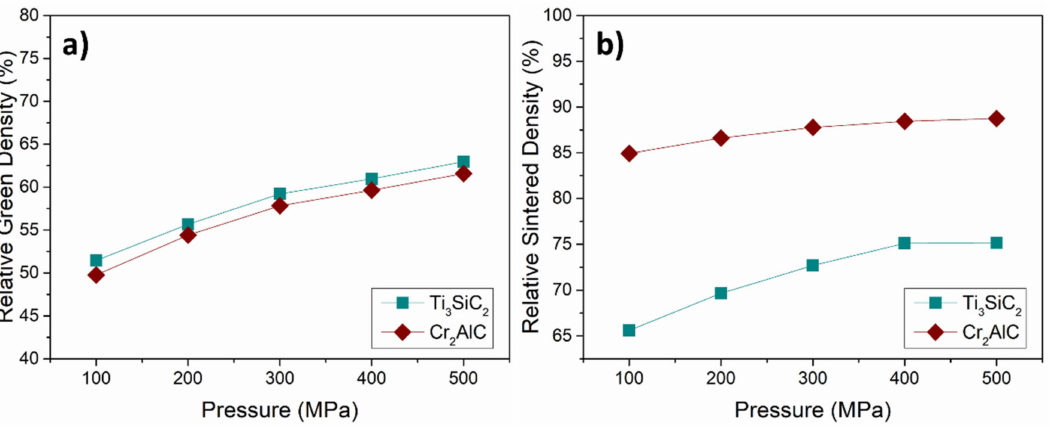
Figure 3. The press and sintering density measurements of Ti 3 SiC 2 and Cr 2 AlC: ( a ) relative green density and ( b ) relative sintered